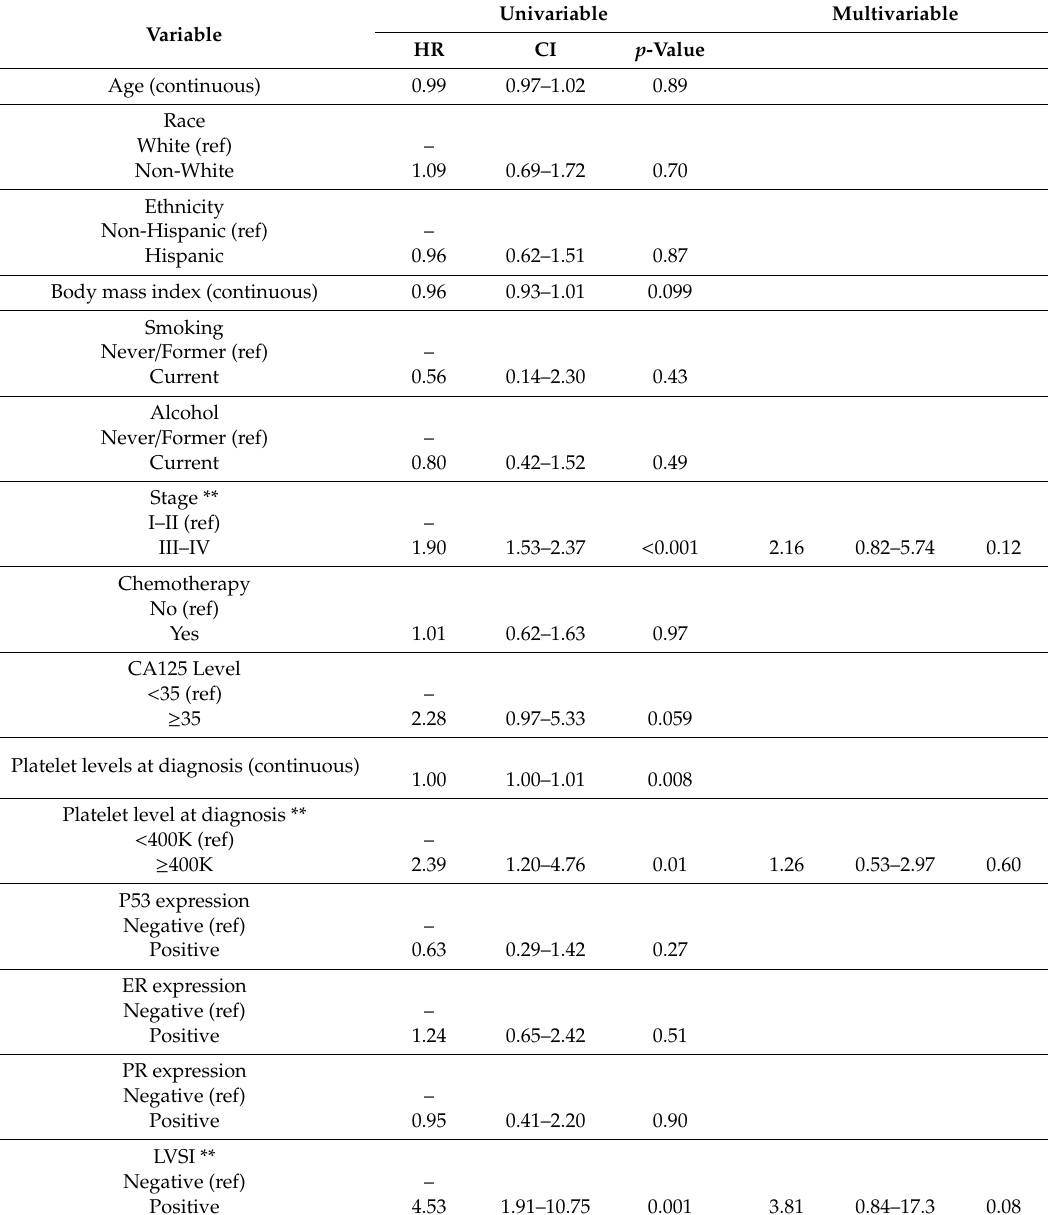
Table 3. Cox proportional hazards models for overall survival among patients with uterine serous